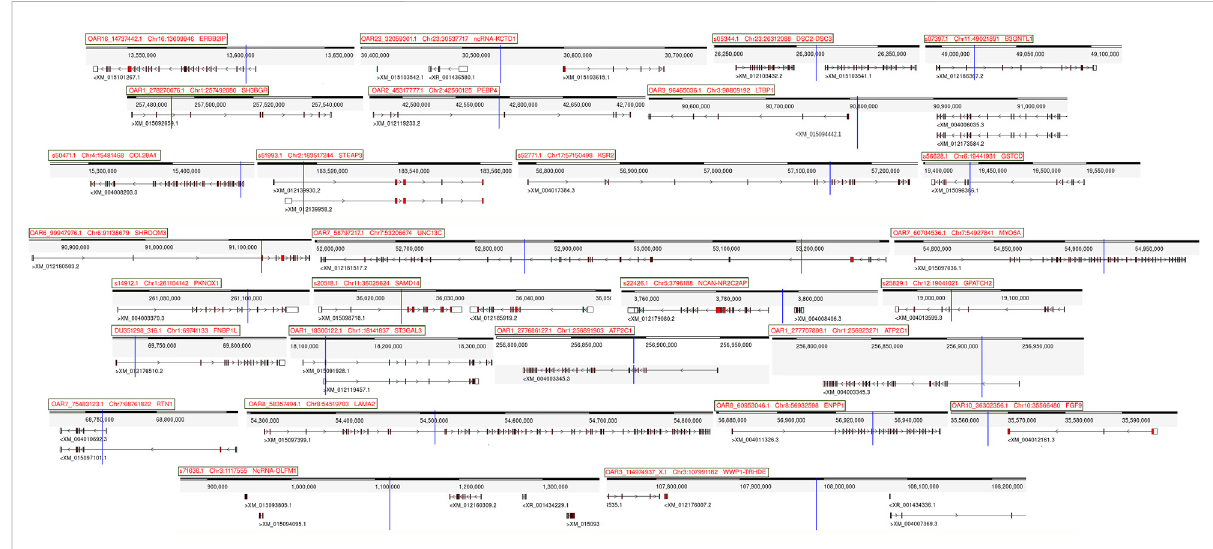
FIGURE 7 The genetic location of the signi fi cant SNPs linked to heat tolerance in sheep